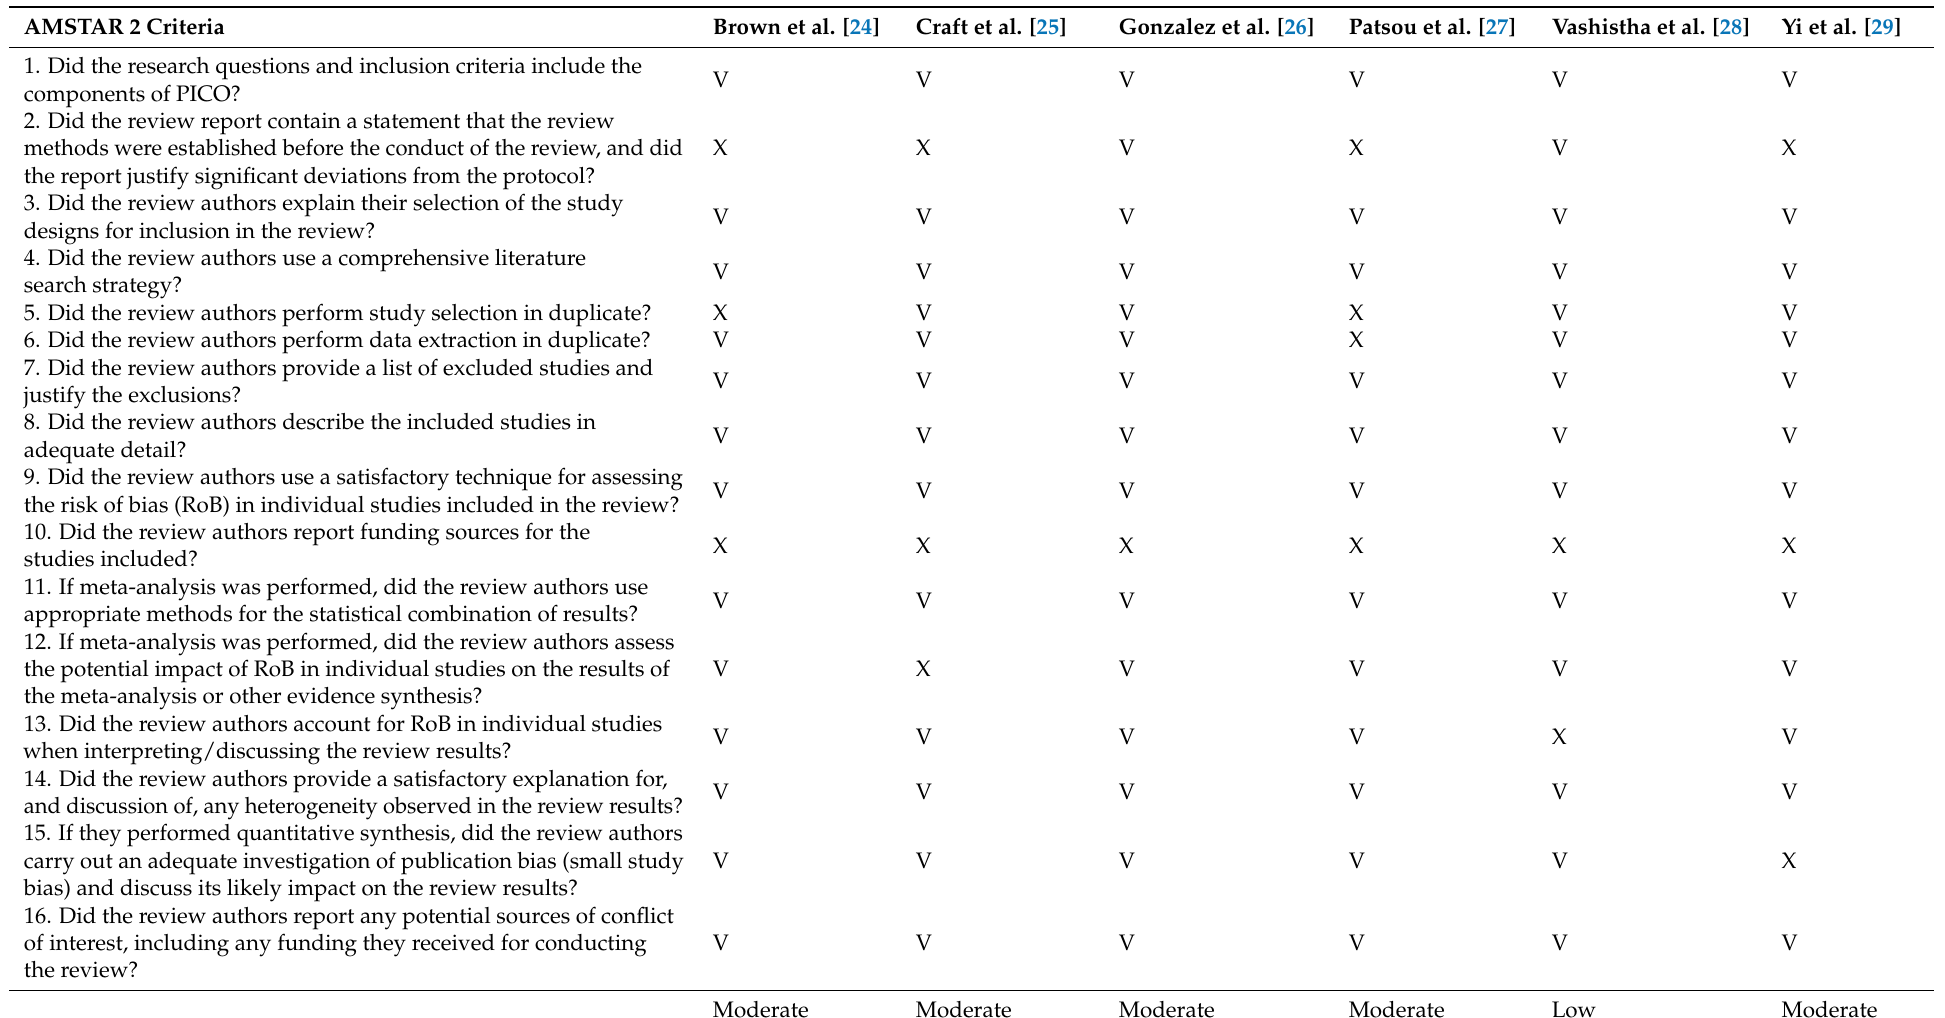
Table 2. Quality of the meta-analyses included in the study according to AMSTAR 2 criteria. AMSTAR 2 Criteria Brown et al. [24] Craft et al. [25] Gonzalez et al. [26] Patsou et al. [27] Vashistha et al. [28] Yi et al.